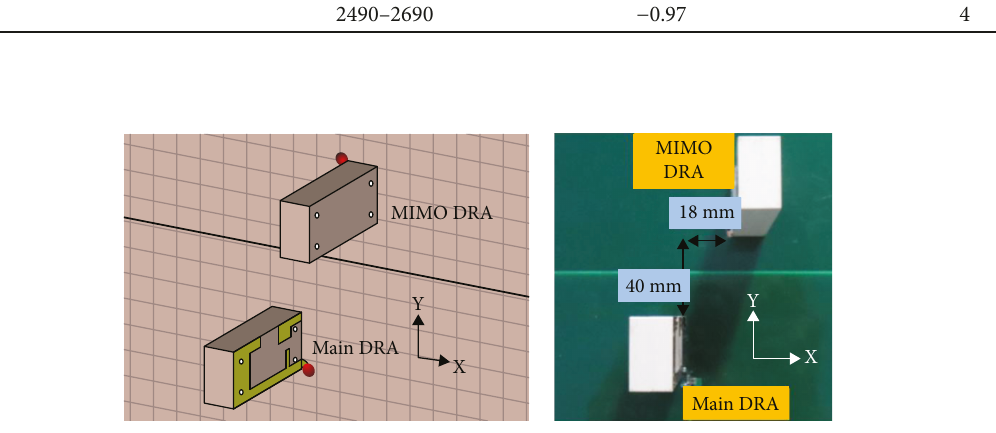
Figure 17: MIMO antenna system in CST and